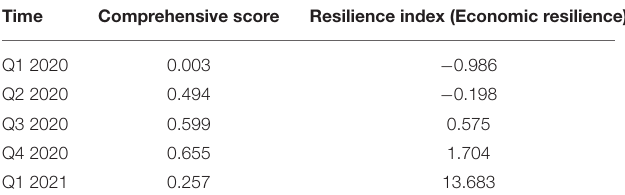
TABLE 2 | Measurement results of economic resilience from the first quarter of 2020 to the first quarter of 2021. Time Comprehensive score